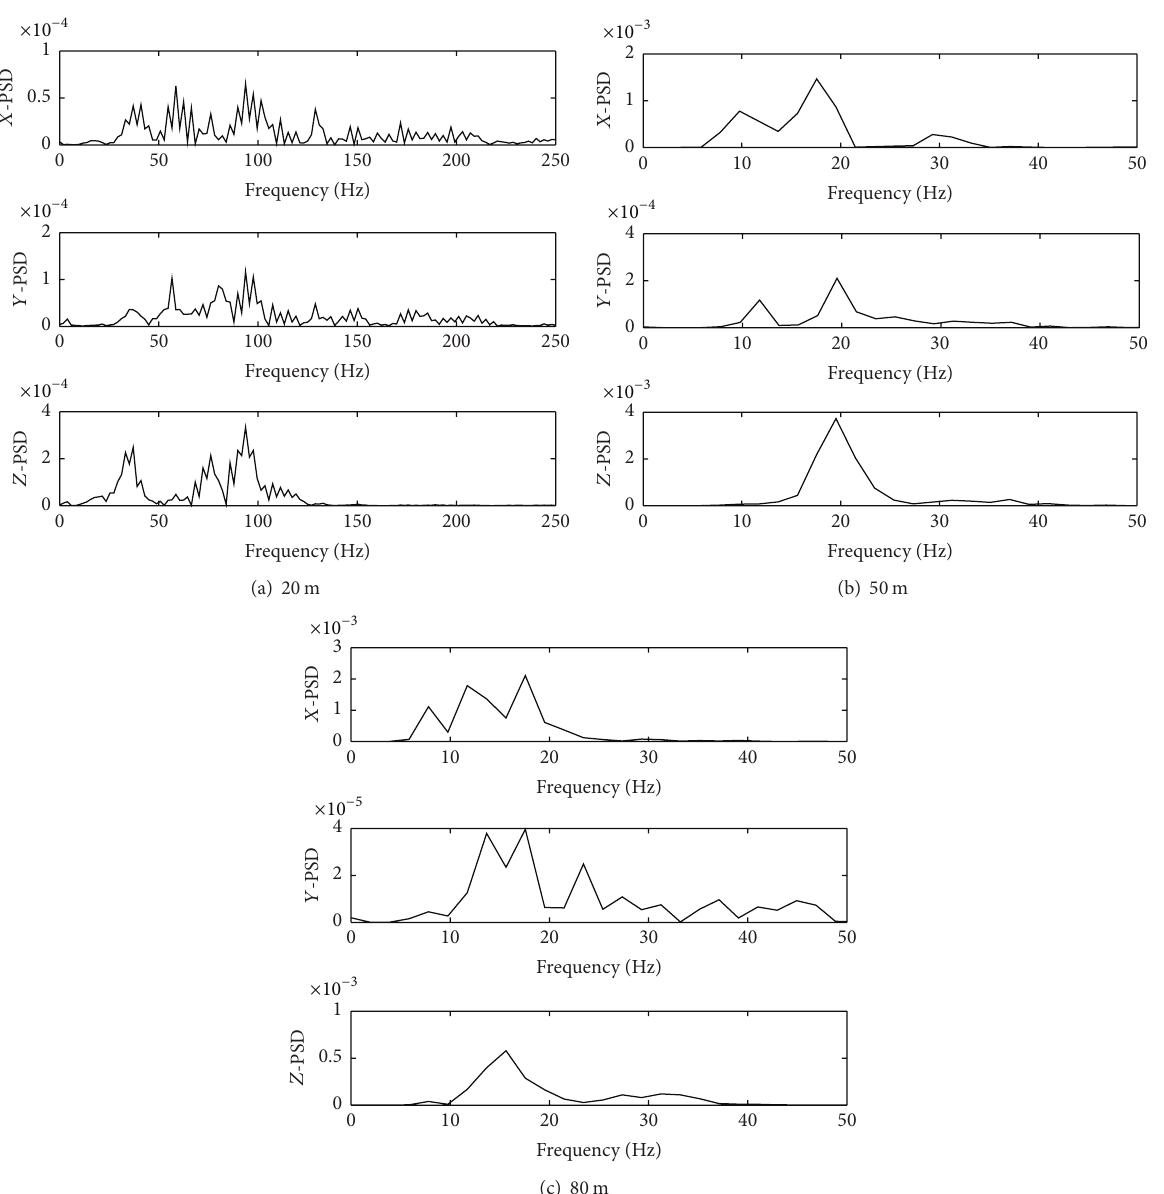
Figure 11: Power spectrum chart of vibration signals at different measuring points in three